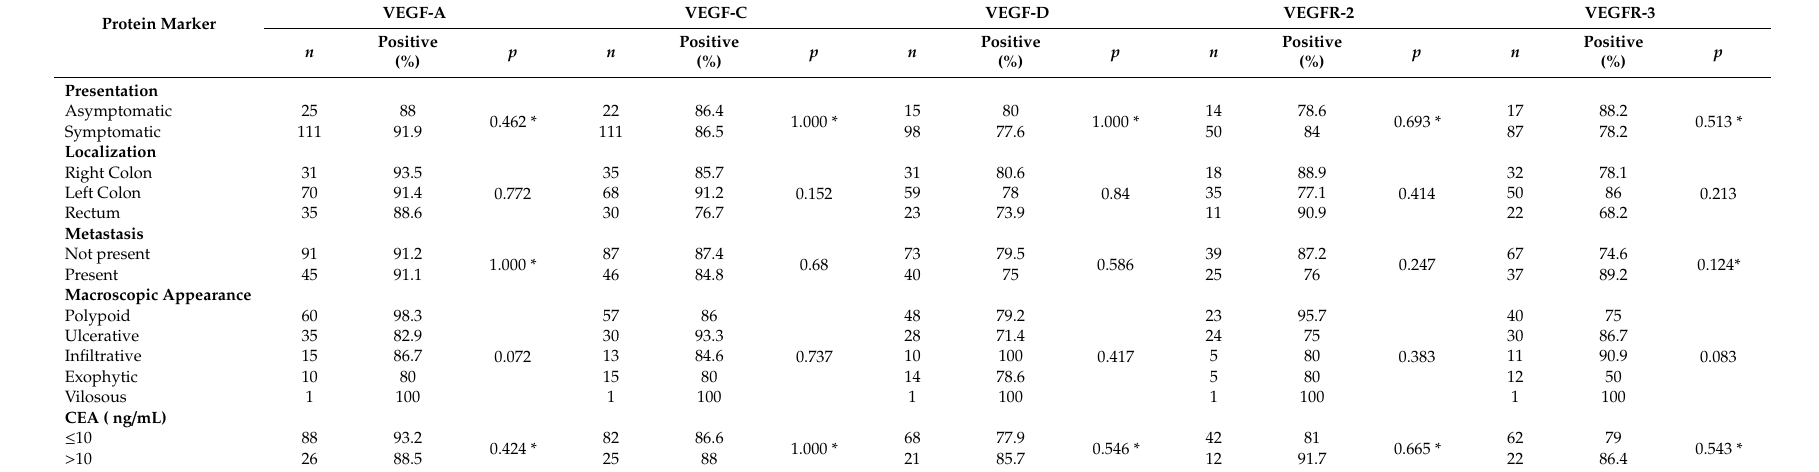
Table 4. Assessment of correlation between CRC lymph node metastasis VEGF-A, VEGF-C, VEGF-D, VEGFR-2 and VEGFR-3 expression and diagnostic / surgical data. * Examined for statistical significance using Fisher’s exact test (when n <